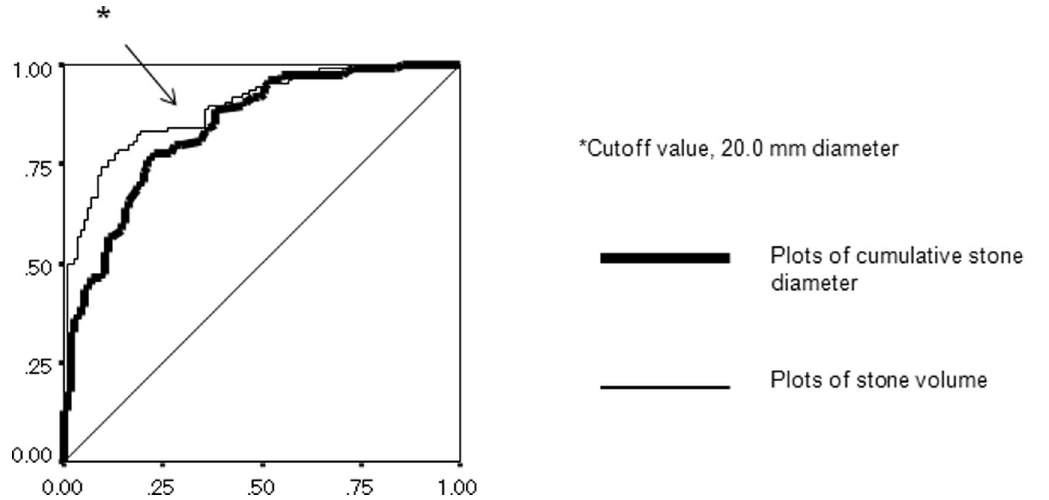
Figure 1. Receiver operating characteristics (ROC) curve of stone-free (SF) status on postoperative day 1 for the two parameters of stone burden, cumulative stone diameter and stone volume (n=243).